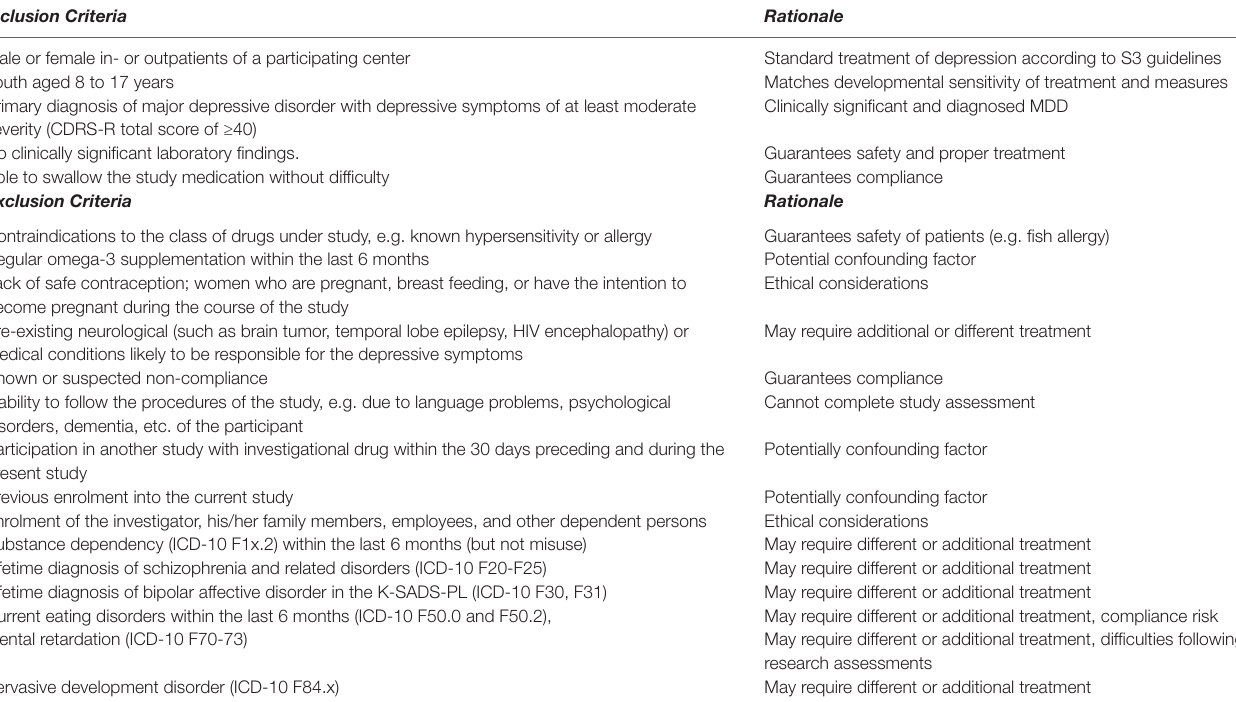
TABlE 1 | Inclusion and exclusion criteria Omega-3-pMDD